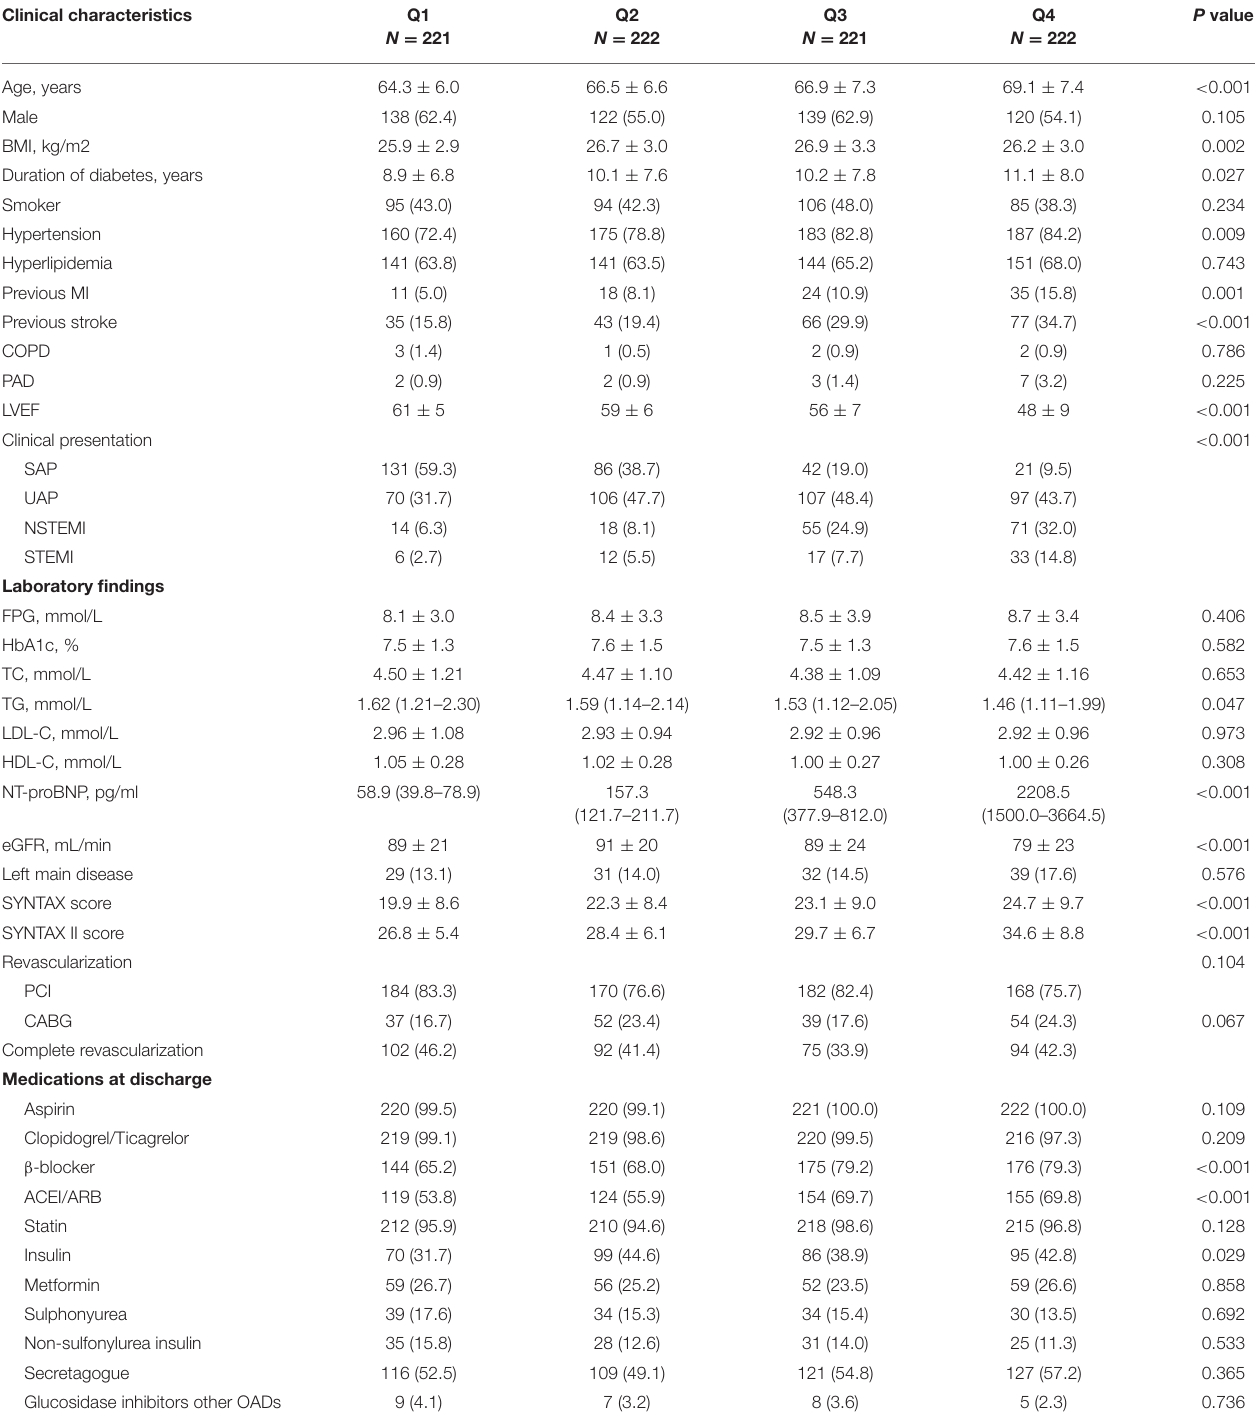
TABLE 1 | Baseline characteristics of the study patients grouped by the NT-proBNP level. Clinical